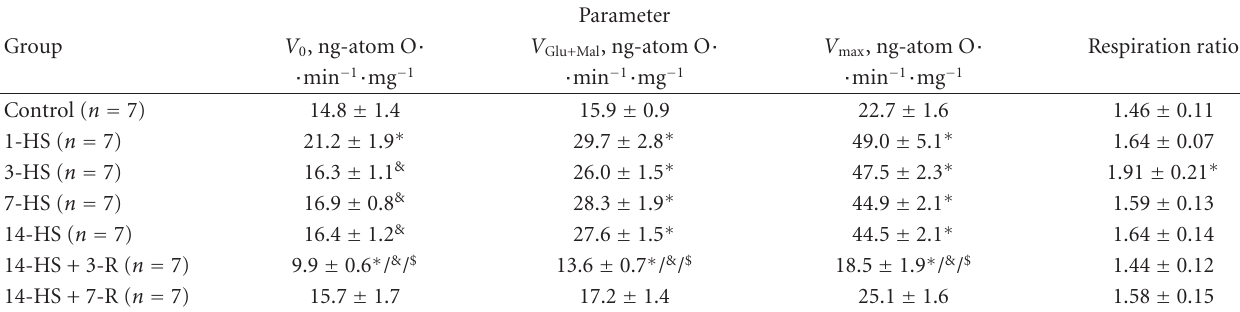
Table 3: Cell respiration of the rat’s left ventricular myocytes under gravitational unloading and subsequent reloading.